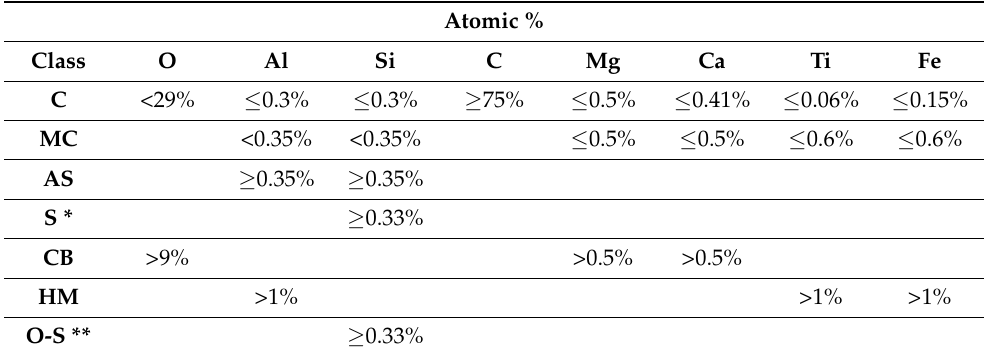
Table 2. SEM-EDX classification criteria for 1–10-micron particles (modified from [7]). Atomic